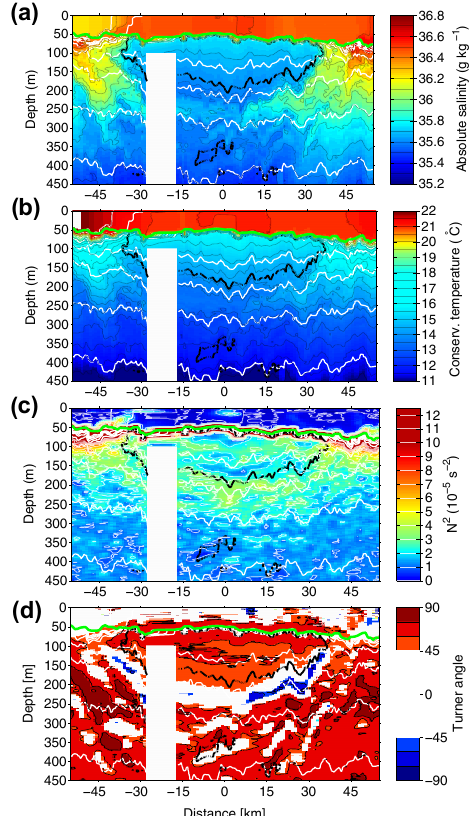
Figure 3. (a) S A , (b) (cid:50) , (c) N 2 , and (d) Turner angle (only seg- ments | 45 to 90 | are shown) from the IFM12 survey. The thick black broken line indicates the 40µmolkg − 1 oxygen concentration indi- cating the low oxygen core (see Fig. 2). The green line indicates the mixed layer base. Selected density anomaly contours are shown as white lines ( (cid:49)σ = 0 . 2kgm − 3